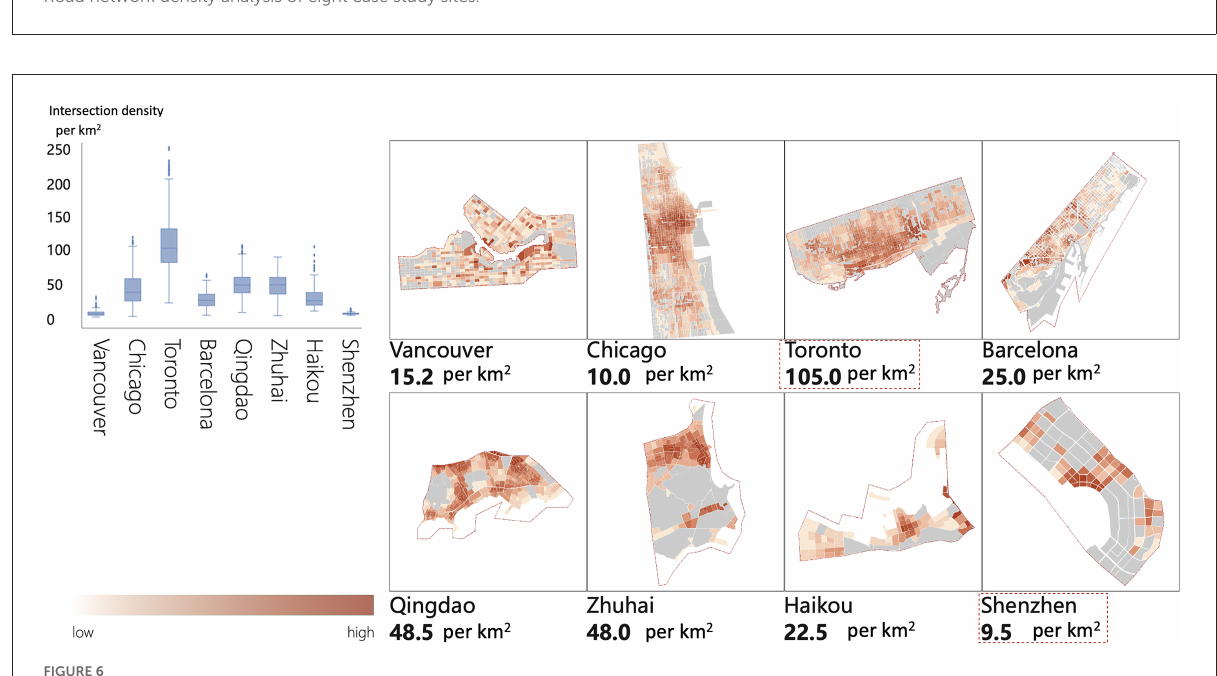
Barcelona are dominated by residences and corresponding living and service functions, while in Qingdao, Shenzhen, and Haikou, the proportion of employment functions is distinctly higher than residential and recreational functions (Figure 9).